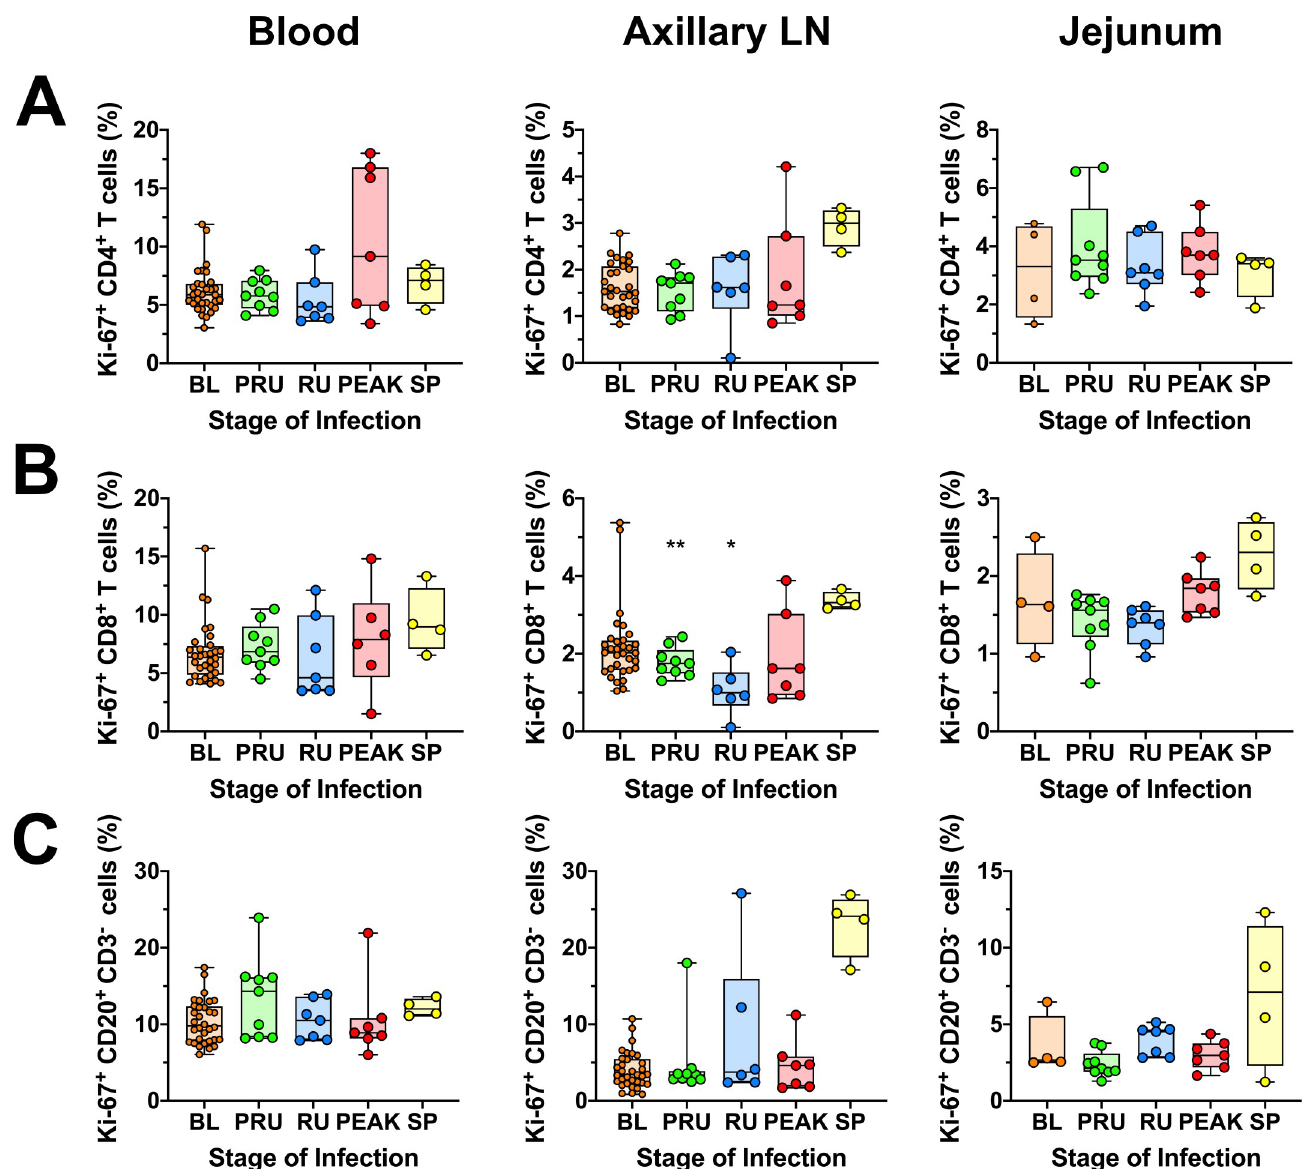
Fig 3. General immune activation and proliferation in blood, jejunum and axillary lymph nodes in SIVsab-infected AGMs. Ki-67 expression on (A) CD4 + T cells; (B) CD8 + T cells; and (C) CD20 + B cells isolated from a variety of different tissues, including blood, jejunum and axillary LN. The five groups are based on the days postinfection, with: BL (baseline, preinfection, orange), PRU (preramp, 1–3 dpi, green) RU (ramp-up, 4–6 dpi, blue), PEAK (peak, 9-12dpi, red) and SP (set- point, 46–55 dpi, yellow). Asterisks indicates statistical significance when compared to baseline values, with � = p < 0 . 05 ; �� = p < 0 . 01 .